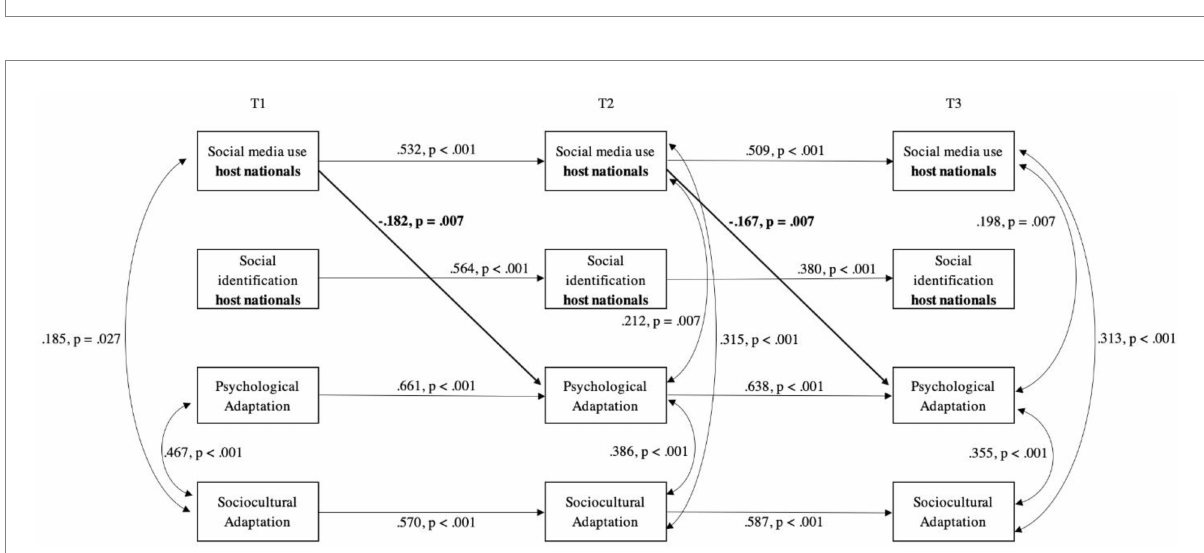
FIGURE 3 Cross-lagged panel model of the relationships between social media use and social identification with host nationals, and psychological and sociocultural adaptation of international students. Only significant paths are shown. Results have been standardized and constrained to equality between time points. Model Fit: χ 2 (38) = 47.956, p = 0.129, CFI = 0.970; TLI = 0.952; SRMR = 0.073; RMSEA = 0.032, 90% CI [0.000, 0.058], p close = 0.819; N =